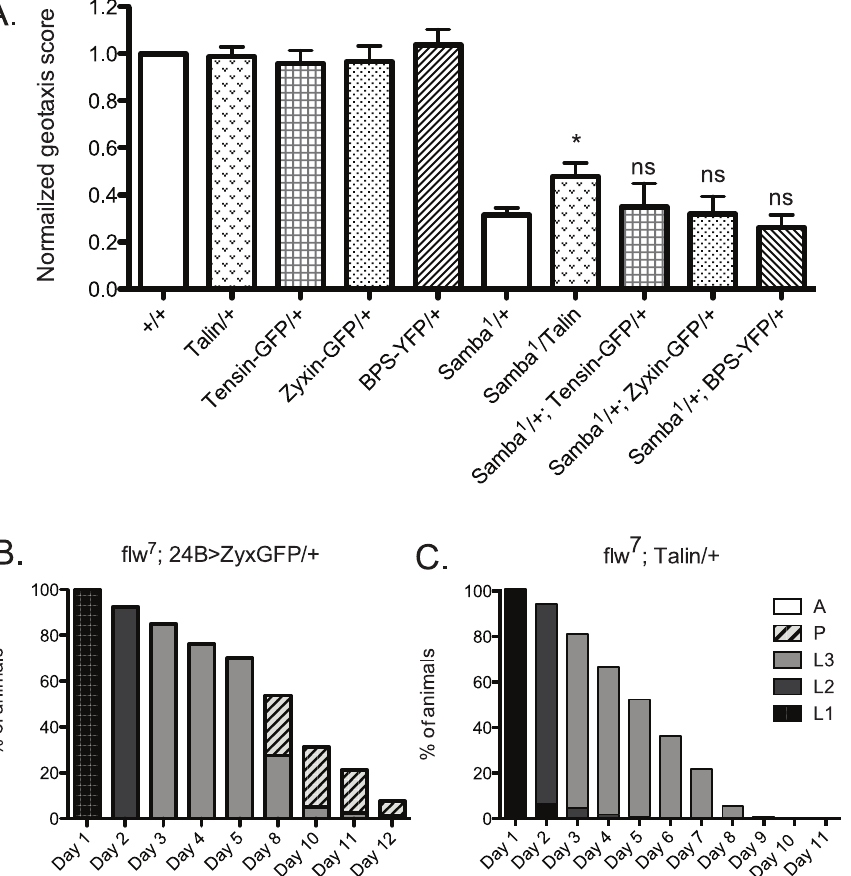
Figure 8. Increased expression of a panel of IAC proteins has little effect on hypercontraction mutants. A) For each genotype, a normalized geotaxis score from . 5 independent assays is plotted as the mean 6 SEM. * indicates p , 0.05, and ns indicates p . 0.05 when compared to the Samba 1 / + data. B) Survival data for flw 7 ; 24B . Zyxin-GFP/ + is not significantly different than flw 7 alone (compare to Figure 2B). Pupae present at day 12 do not progress to adulthood. C) Survival data for flw 7 ; Ubi-Talin/ + shows that larval lethality is increased compared to flw 7 alone (see Figure 2B).